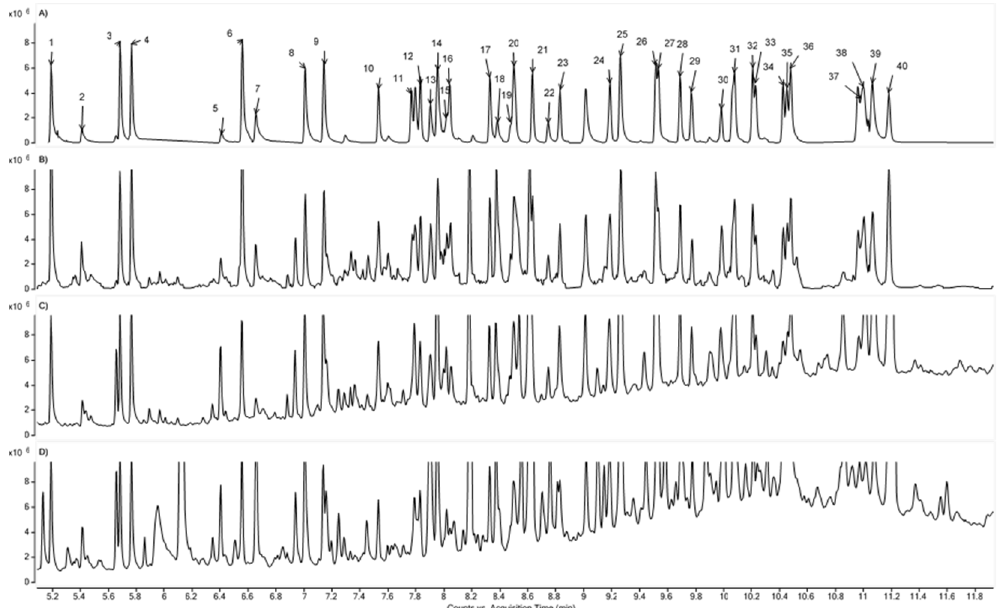
Figure 1. Sample chromatograms of ( A ) the standard mixture (2 µg/mL) and extracts from the samples: ( B ) S1, ( C ) S2, ( D ) S3 with added standards at 2 µg/mL. The labels above the peaks on the chromatogram ( A ) correspond to the No column in Table 1.